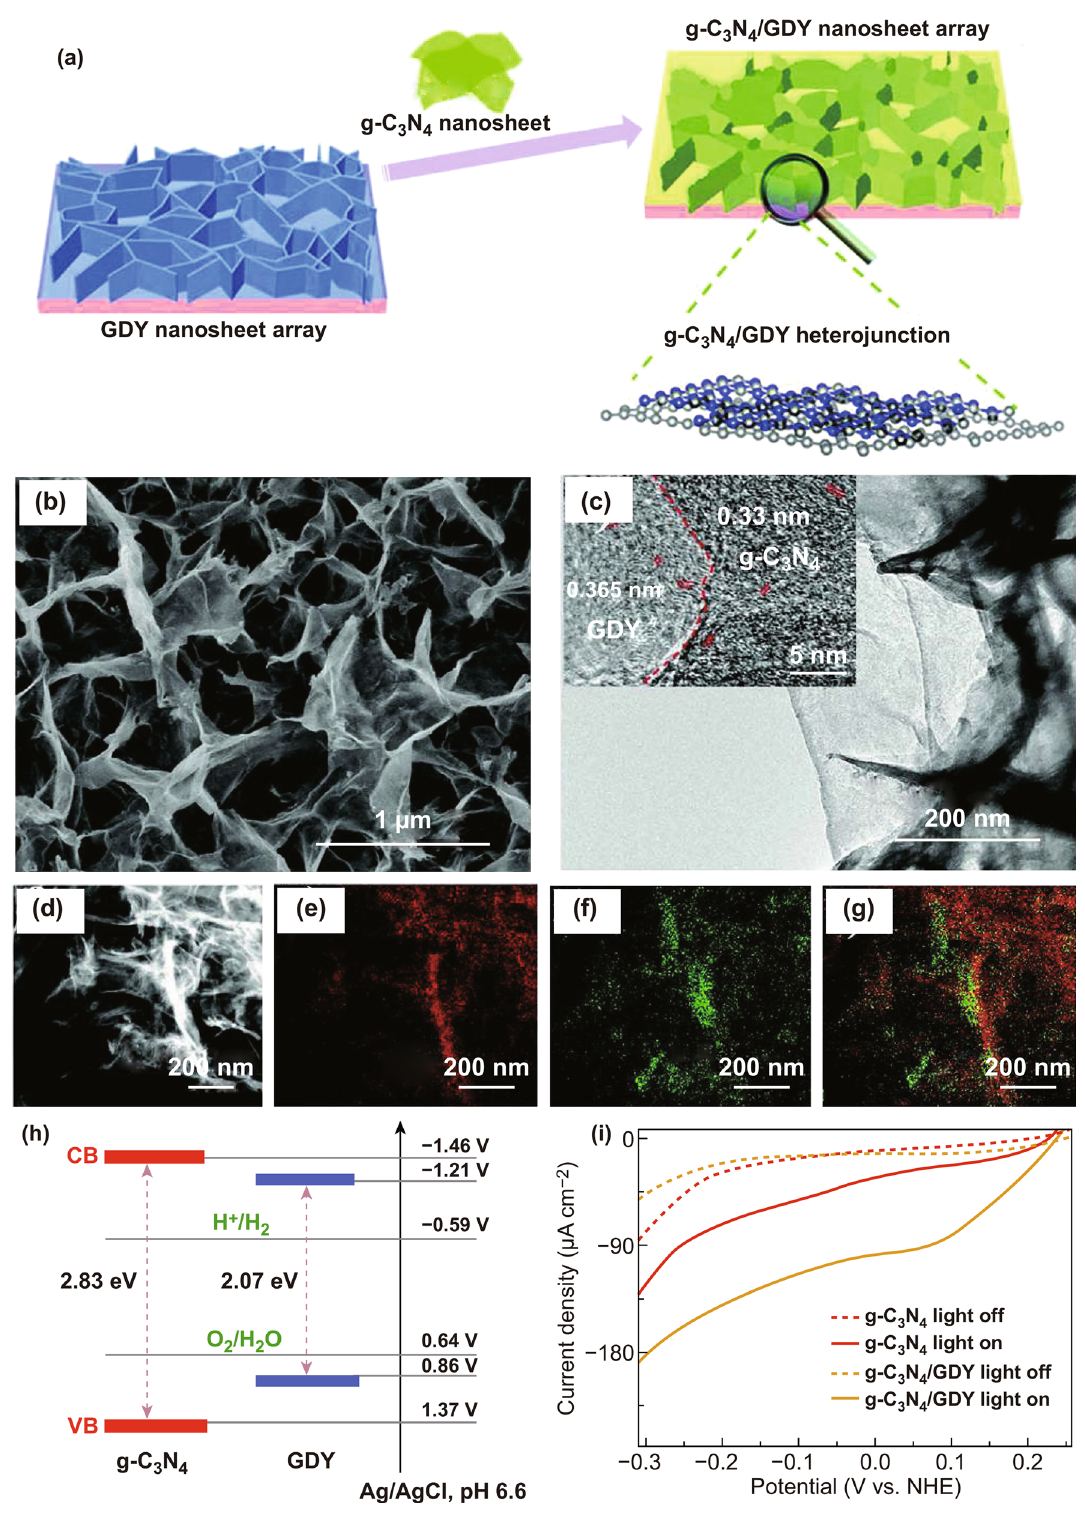
Fig. 4 a Synthesis scheme of 2D/2D g-C 3 N 4 /GDY; b SEM and c TEM images of g-C 3 N 4 /GDY; d high-angle annular dark field (HAADF) image, e C, f N, and g mixed elemental mapping of g-C 3 N 4 /GDY; h band alignments of g-C 3 N 4 and GDY; i linear sweep voltammetry of g-C 3 N 4 /GDY under light on and off. Reproduced with permission from Ref. [92]. Copyright 2018